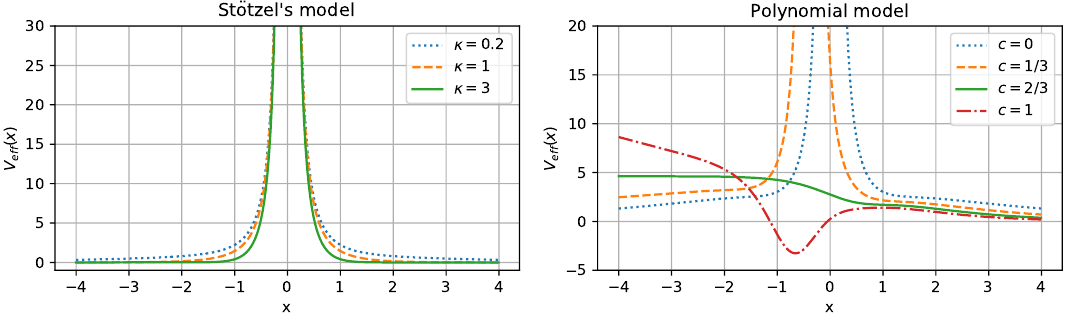
Figure 3 . Plots of V eff ( x ) . For polynomial model with c = 2 / 3 , V eff ( x ) becomes finite, and √ approaches to 4 3 2 e − 1 12 ≈ 4 . 637 as x → −∞